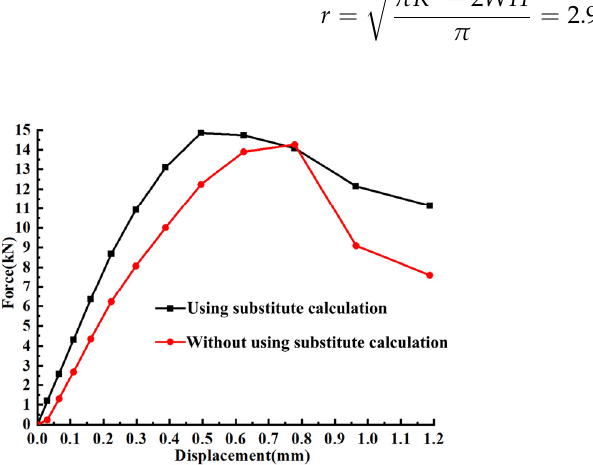
Figure 16. Load–displacement curves using substitute calculations.